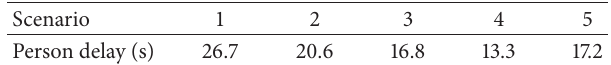
Table 7: Average person